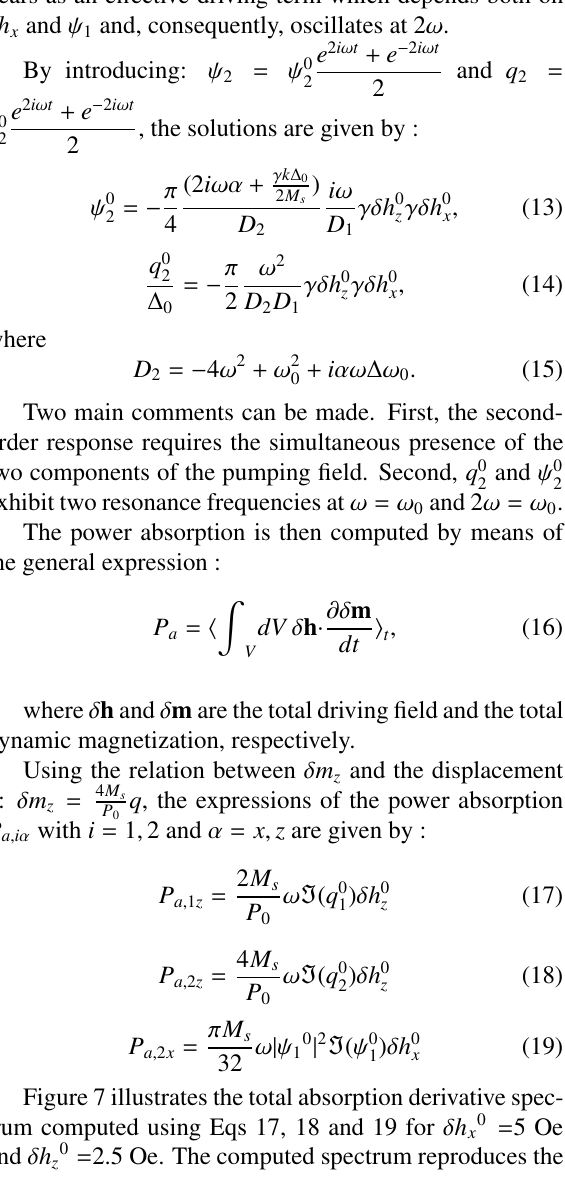
Figure 7. Zero-field absorption derivative spectrum computed from Eqs.17, 18 and 19. The magnetic parameters are those re- ported in Sec. 2 except α = 0.006. The sample is excited by an oblique pumping field with an in-plane component δ h x along the stripe direction and an out-of plane component δ hz . δ h x 0 = 5 Oe and δ h z 0 = 2.5